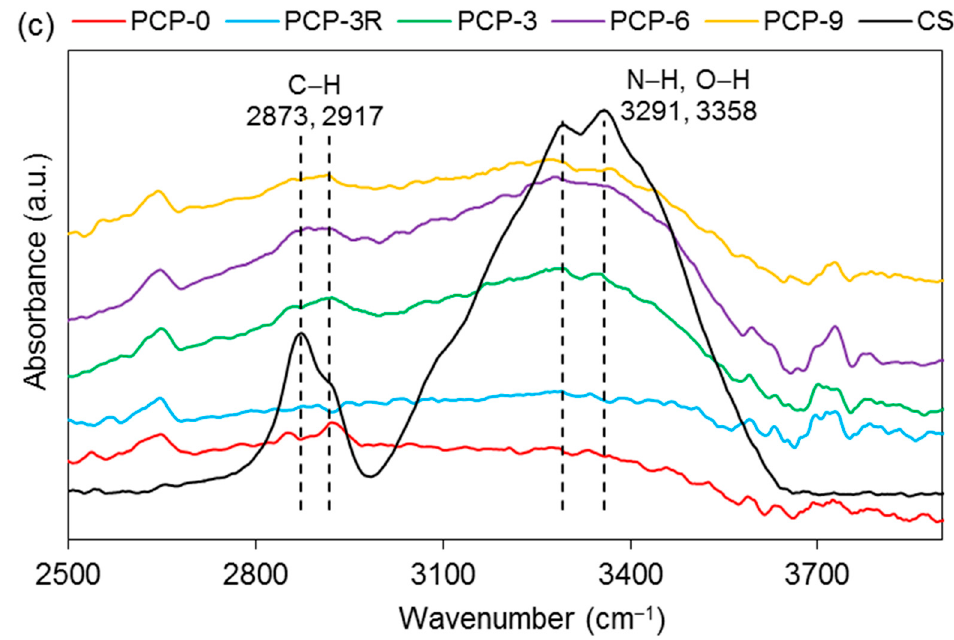
Figure 6. FTIR spectra of the coated/uncoated fibres and the pure CS powder at the band range of ( a ) 400–1300 cm − 1 , ( b ) 1300–1800 cm − 1 and ( c ) 2500–3800 cm − 1 .